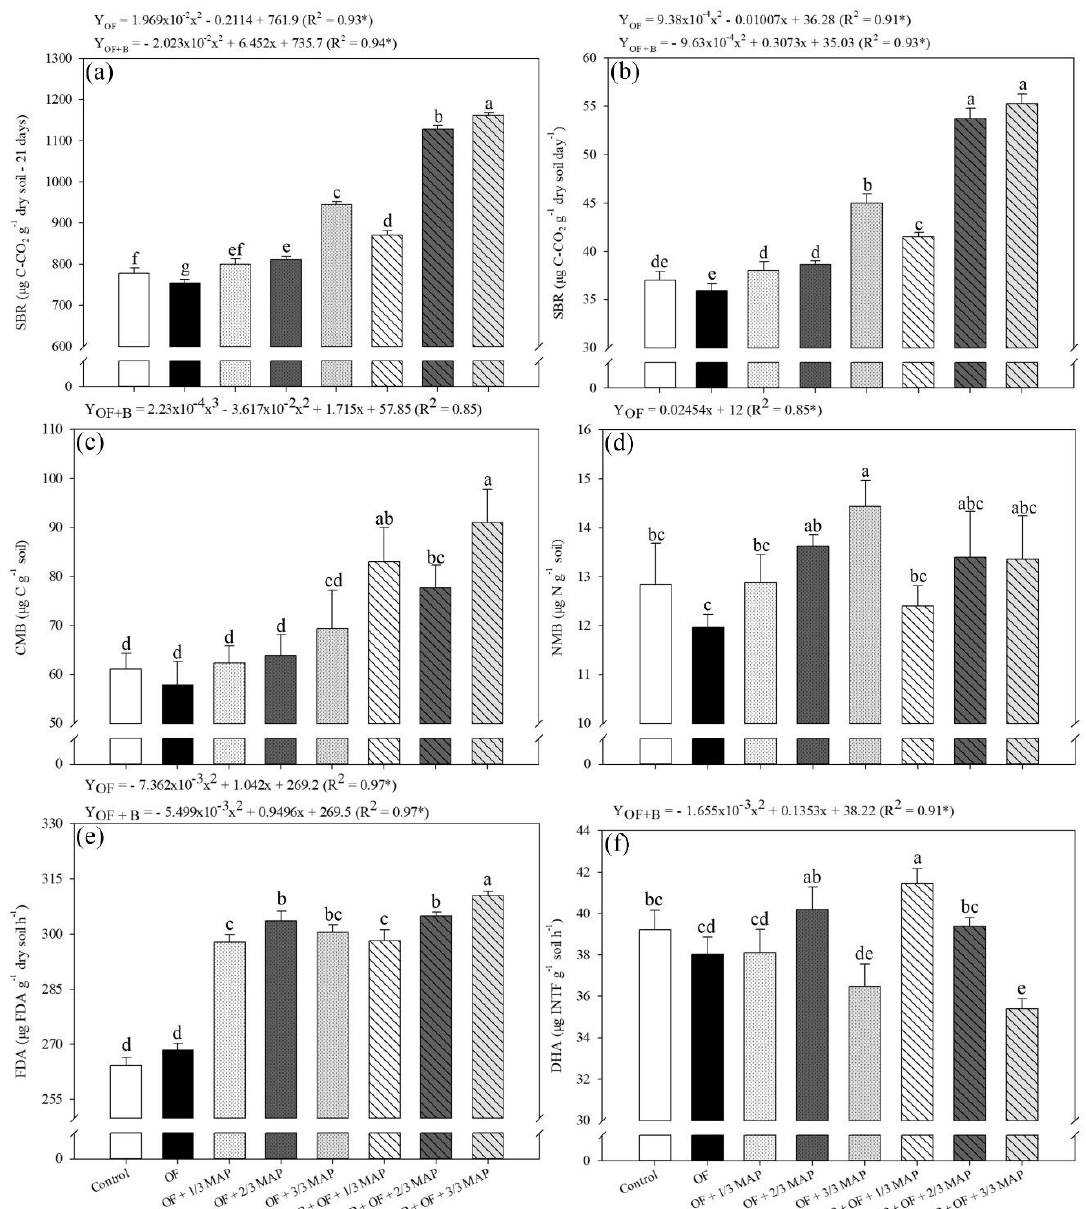
Figure 5. Soil basal respiration (SBR) accumulated in 21 days and per day ( a , b ); carbon (CMB) and nitrogen of the microbial biomass (NMB) ( c , d ); hydrolysis of fluorescein diacetate (FDA) ( e ); and dehydrogenase activity ( f ) in the soil of sugarcane cultivation under the association of organomineral fertilizer (OF), B. velezensis (B), and doses of mono ammonium phosphate (MAP). Means followed by the same letter do not differ from each other by the Tukey test at 5% probability. The error bars express the standard deviation of the mean (n = 4). The regression equations and R 2 above the figures include the MAP doses associated with organomineral fertilizer (OF) and with organomineral fertilizer + B. velezensis (OF + B) at the 5% significance level (*).